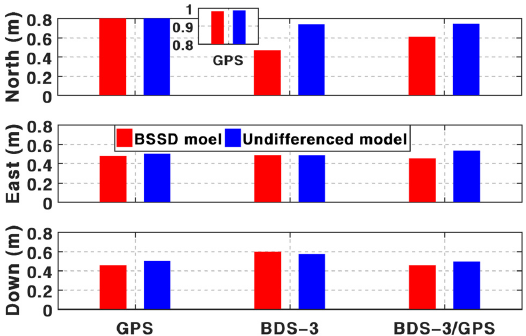
Figure 17. Mean maximum position drifts of different GNSS for BSSD PPP/INS/ODO TCI and undifferenced PPP/INS/ODO TCI.